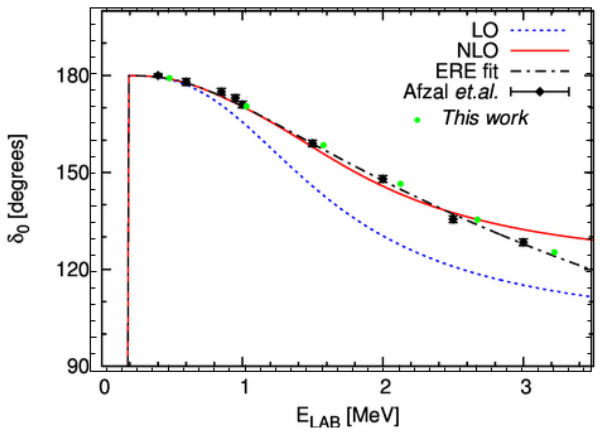
( E ) obtained with Λ = 300MeV. n 13